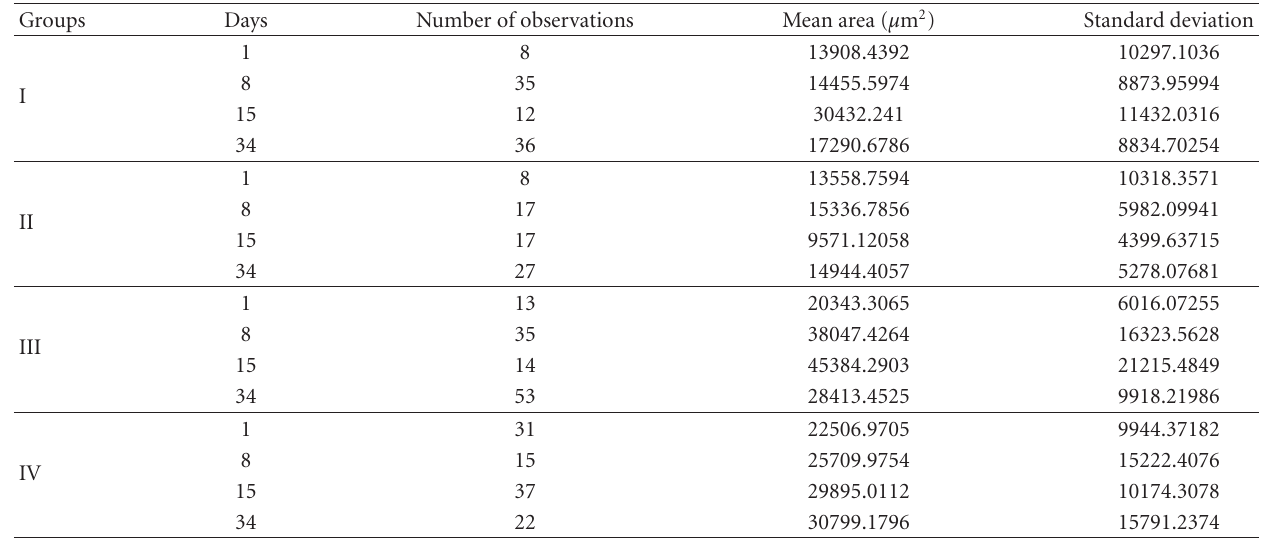
Table 2: Number of pulmonary granulomas recorded, with the mean and standard deviation values from the di ff erent groups of mice, which were euthanized after 1, 8, 15, and 34 days.